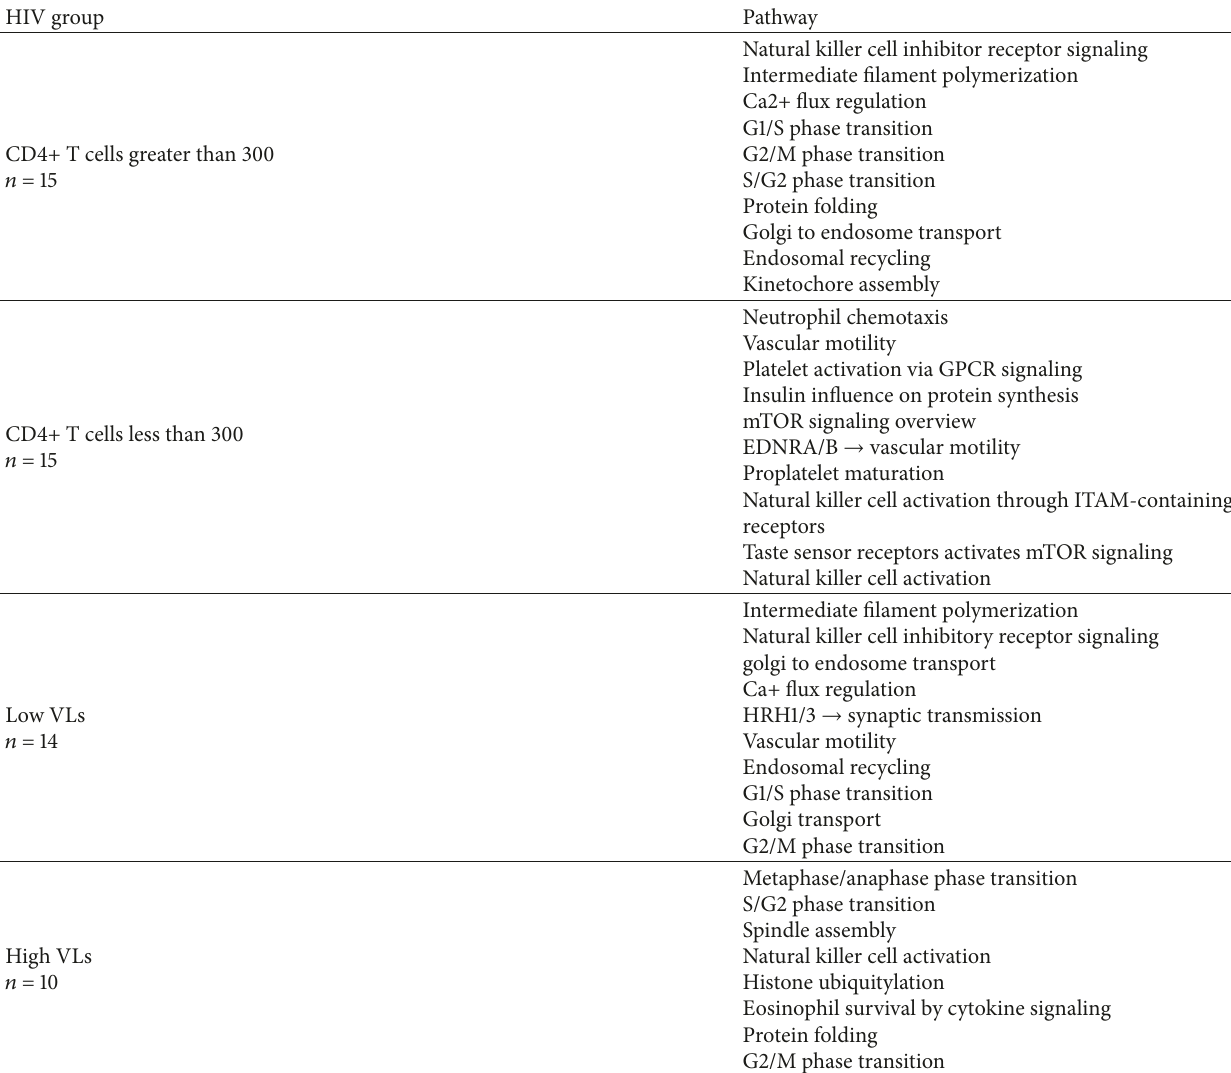
Table 7: Comparison of pathways between HIV+ groups from Pathway Studio